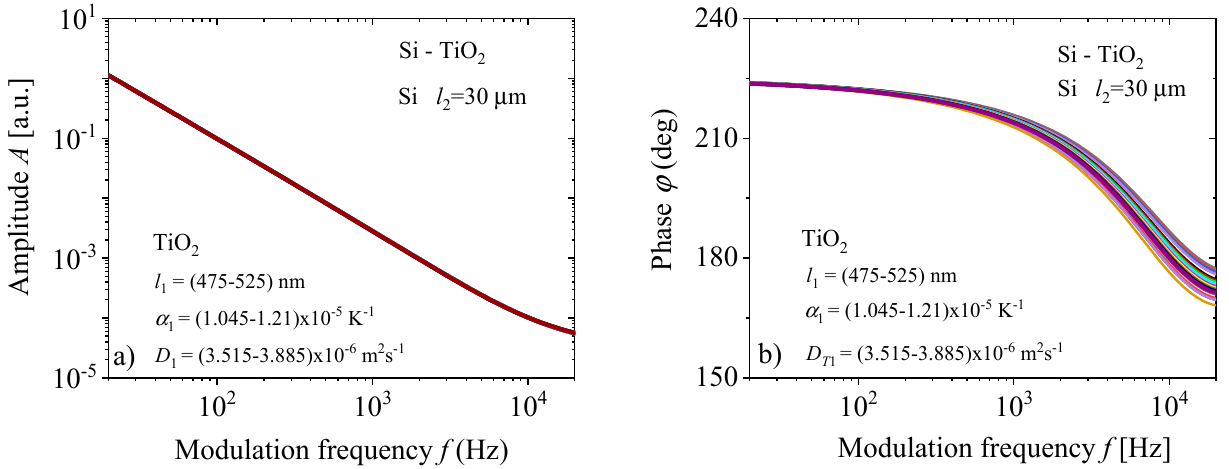
Figure 5. ( a ) Amplitudes, A , and ( b ) phases, ϕ , of the two − layer model: TiO 2 thin − films deposited on the Silicon substrate, obtained by changing parameters of the thin − film, diffusivity D T 1 , expansion α T 1 and thickness l 1 .